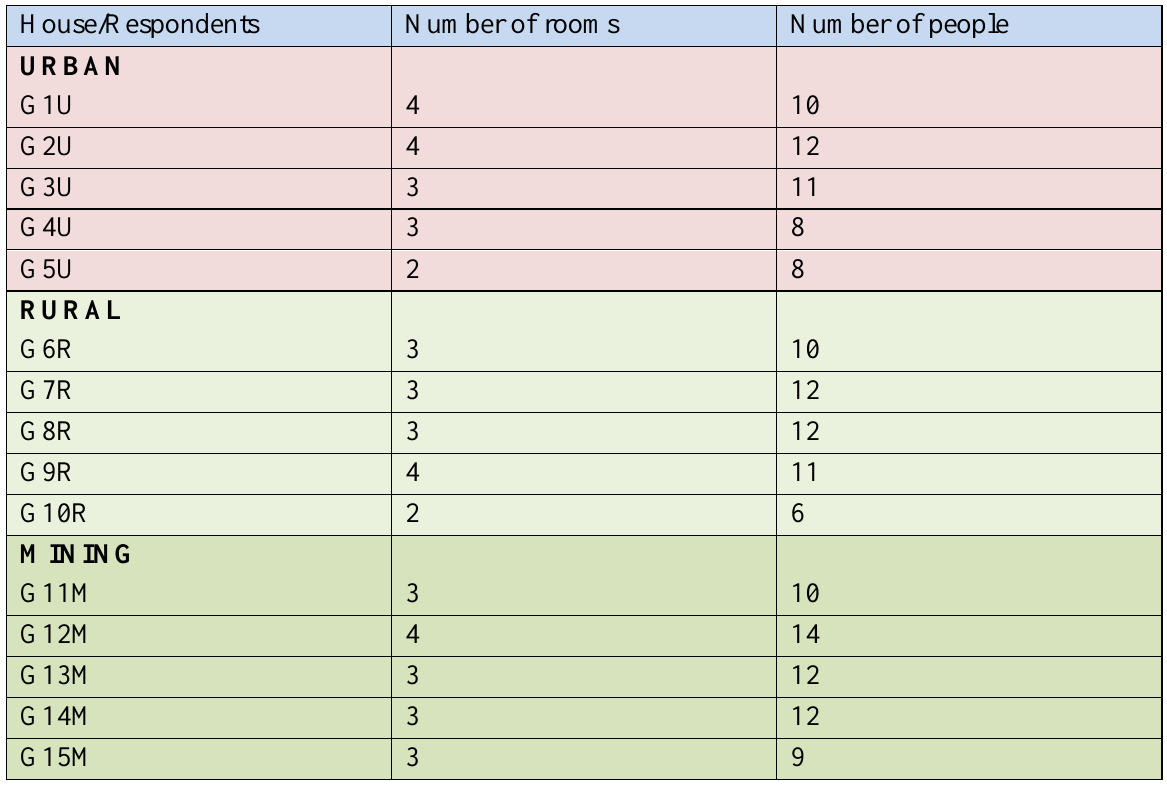
Table 5.6: The house size of the respondents House/Respondents Number of